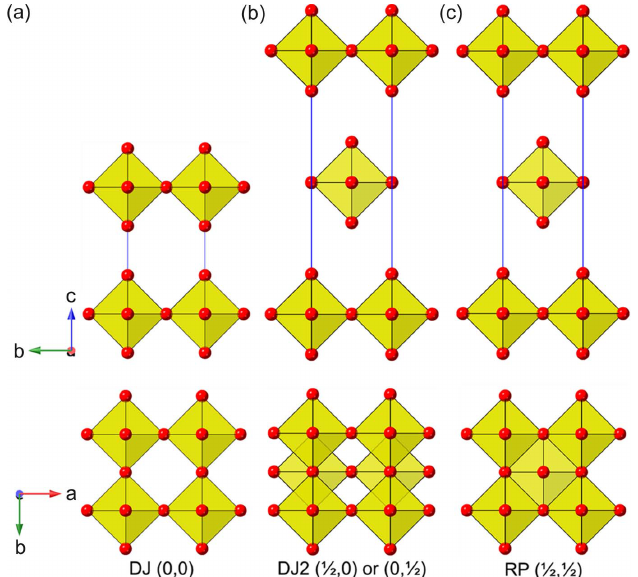
Figure 2 Undistorted structures of the simplest n = 1 layered perovskites viewed between layers (top) and along the layer stacking direction (bottom) highlighting the completely ‘eclipsed’, partially ‘staggered’ and comple- tely ‘staggered’ adjacent layers of the (0, 0) and (1/2, 0) Dion–Jacobson (DJ and DJ2, respectively) and (1/2, 1/2) Ruddlesden–Popper (RP)